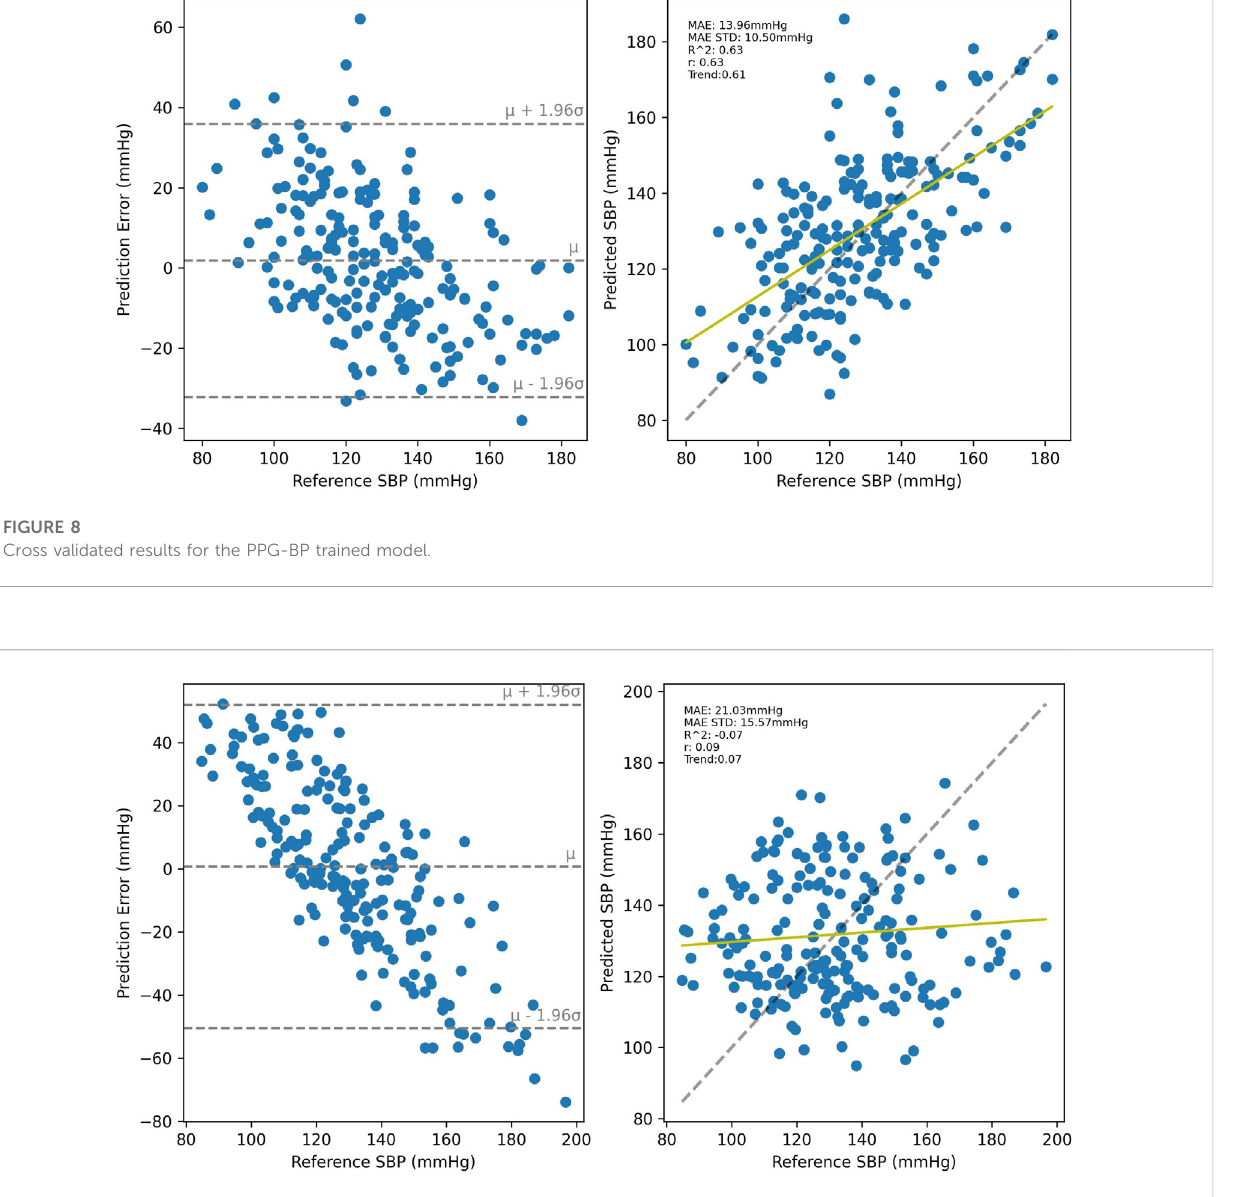
FIGURE 9 Results of the PPG-BP trained model tested with the UCI data. A random sample of the BP estimations are shown but the metrics are for the entire